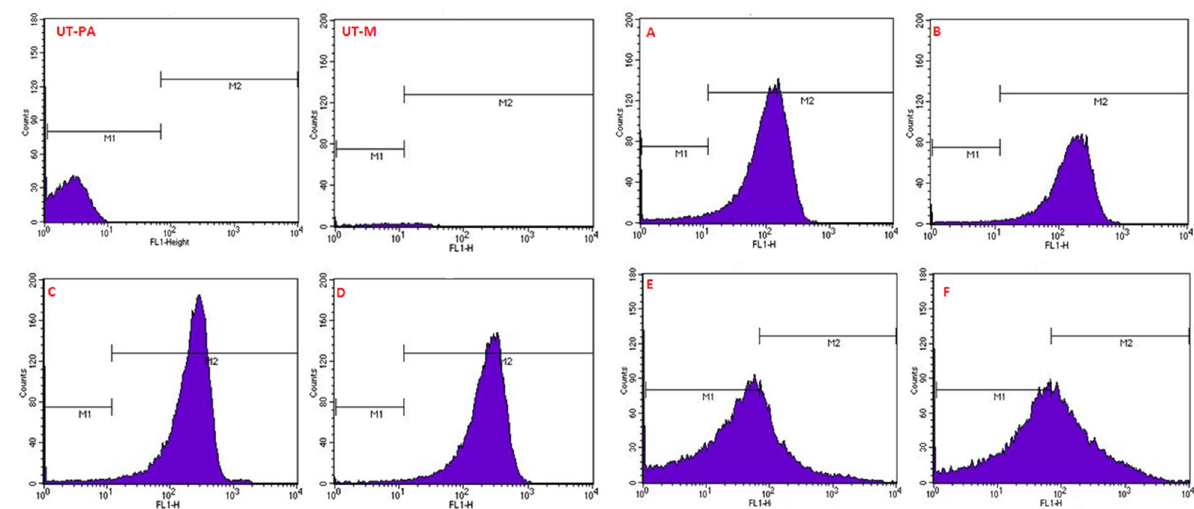
Figure 9. Evaluation of intracellular ROS production in P.aeruginosa and MRSA cells following treatment with LP, Cu-NPs and LP + Cu-NPs. The concentration selected for the study was based on their respective MIC values. H 2 O 2 treated cells were used as positive control while cells alone were used as negative control.